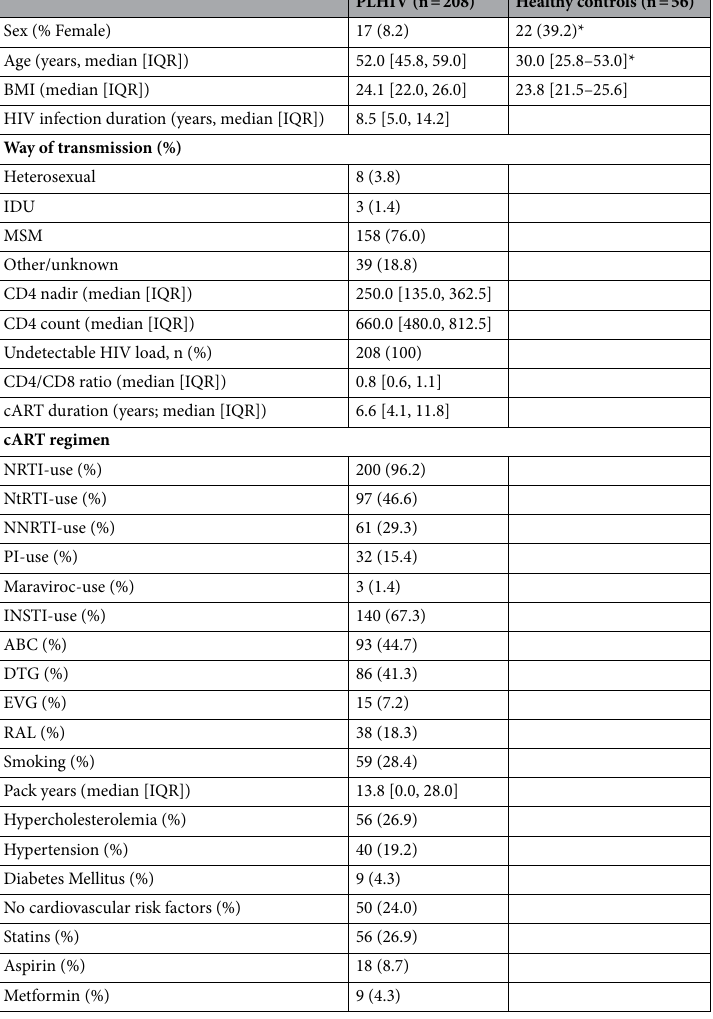
Table 1. Baseline characteristics. BMI body mass index, cART combination antiretroviral therapy, NRTI nucleoside reverse transcriptase inhibitor, NtRTI nucleotide reverse transcriptase inhibitor, NNRTI non- nucleoside reverse transcriptase inhibitor, PI protease inhibitor, INSTI integrase inhibitor, ABC abacavir, DTG dolutegravir, EVG elvitegravir, RAL raltegravir. *Significantly different between